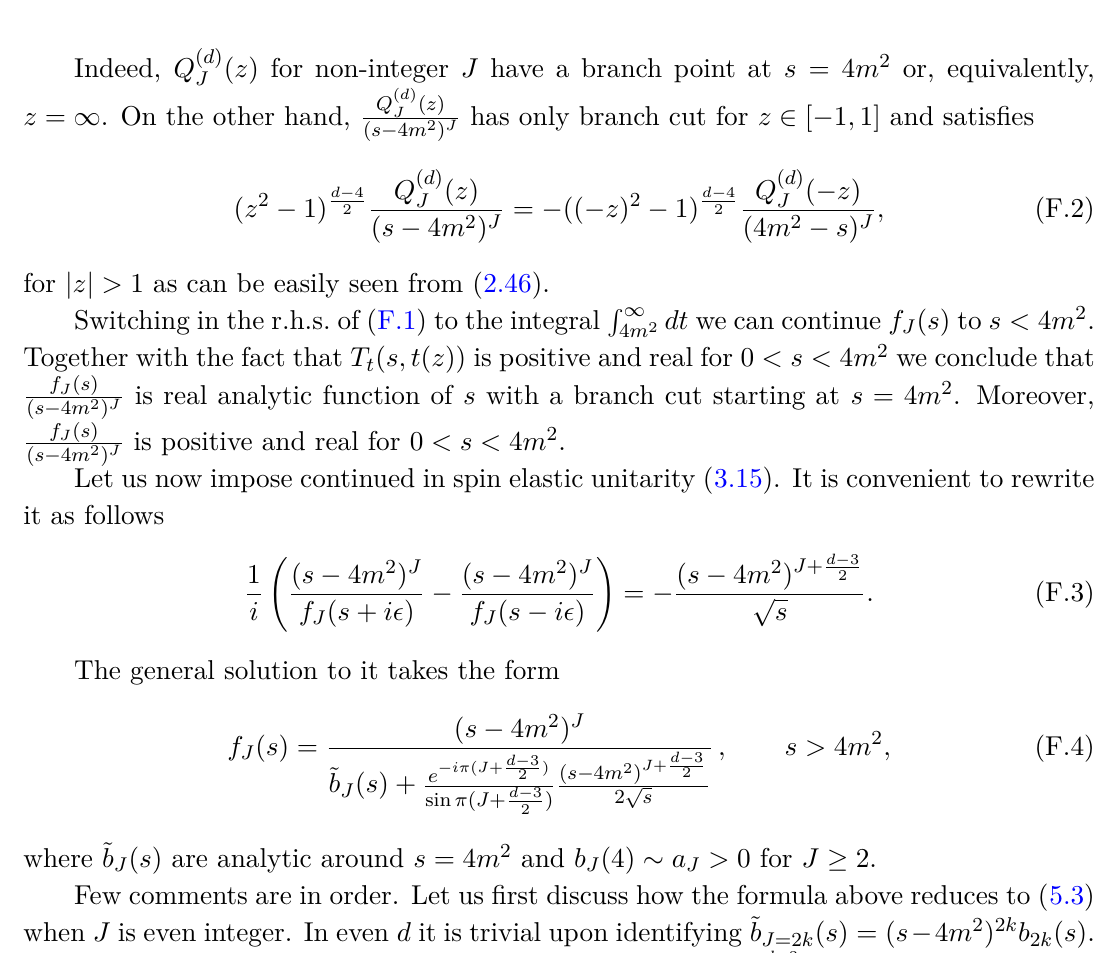
. Red { 2 , 0 , 0 ,... } < t < t < t { 1 , 0 , 1 , 0 ,... } { 0 , 2 , 0 ,... } { 2 , 1 , 0 ,... } { 4 , 0 ,... }